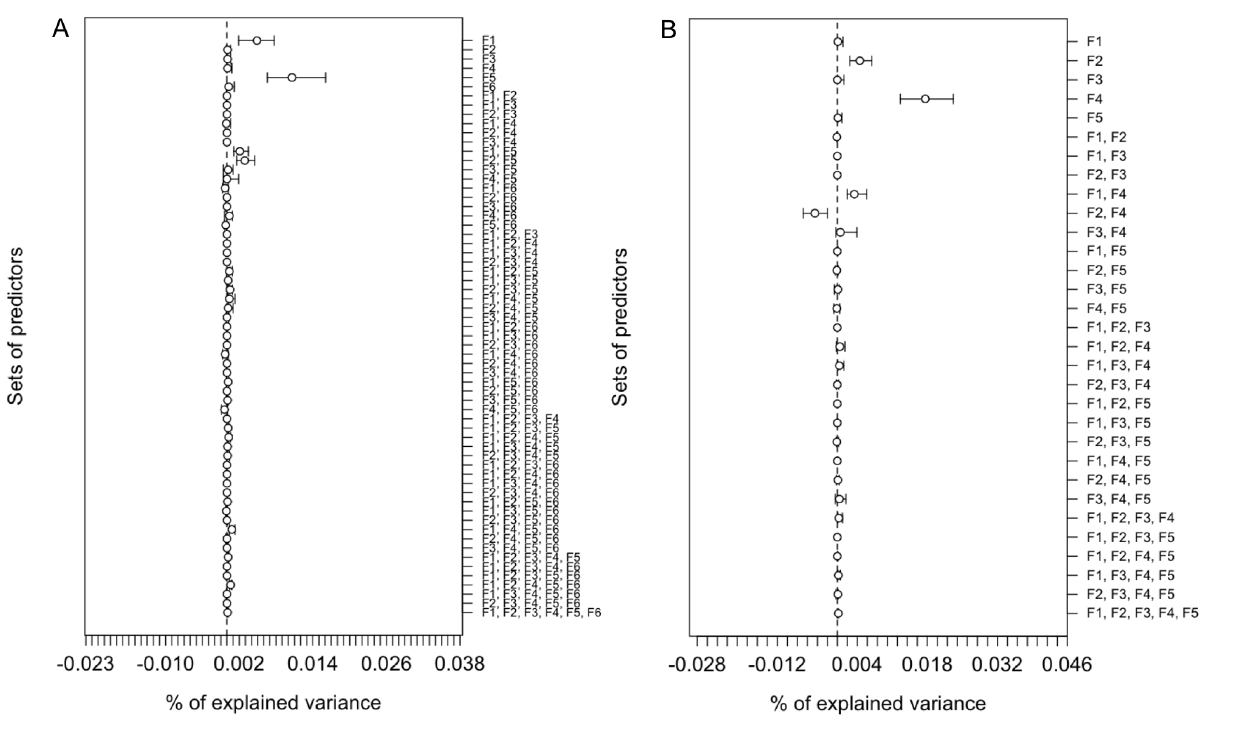
Fig. 4. Plots of explained variance (%) for combinations of all tested variables. (A) Commonality coefficients for the archaeological surface, with 95% bootstrap confidence intervals (F1 = language family residuals, F2 = fish trap residuals, F3 = midden residuals, F4 = ice and snow residuals, F5 = waterway residuals, F6 = ruggedness residuals). (B) Commonality coefficients for the modern surface, with 95% bootstrap confidence intervals (F1 = modern settlement residuals, F2 = forestry residuals, F3 = ice and snow residuals, F4 = waterway residuals, F5 = ruggedness